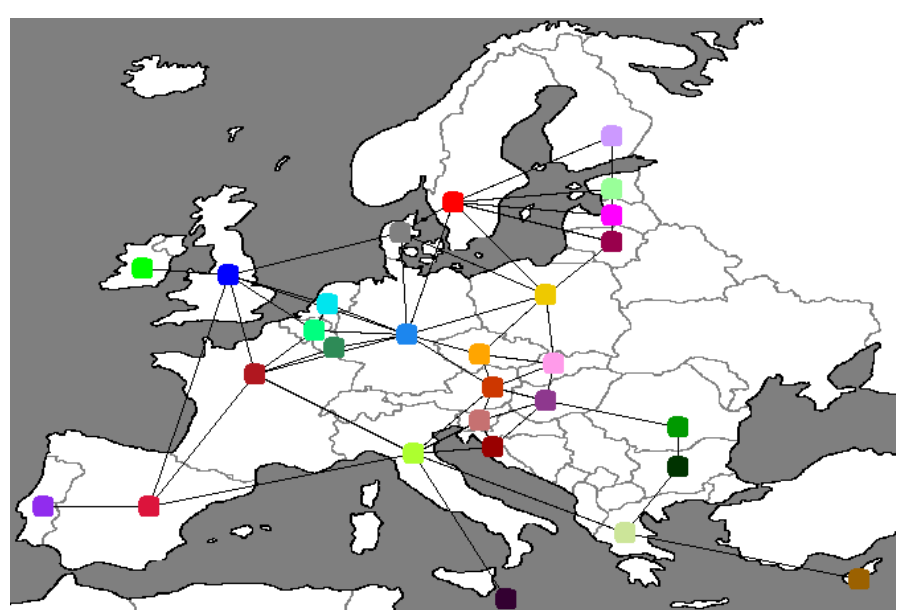
Figure 1. European Union Network Based on its Geographical